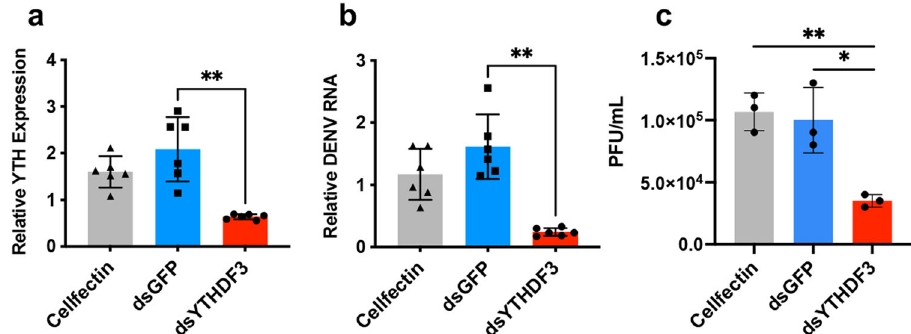
Fig. 6 m 6 A YTHDF3 reader modulates DENV replication in Ae. aegypti cells. a Con fi rmation of silencing of YTHDF3 homologue by dsRNA (dsYTHDF3) in Aag2 cells. dsRNA to GFP (dsGFP) was used as a negative control in addition to Cellfectin transfection reagent only. b , c Inhibition of DENV replication by YTHDF3 silencing. Aag2 cells transfected with dsRNA targeting GFP or dsRNA targeting YTHDF3 were infected with DENV 72 h after transfection. Cells were collected at 72 hpi for RNA extraction and quanti fi cation of DENV RNA by RT-qPCR ( b ), and the supernatants were harvested for quanti fi cation of DENV virions by plaque assay ( c ). Error bars represent mean ± S.D. * p < 0.05; ** p < 0.01. ANOVA test with post hoc